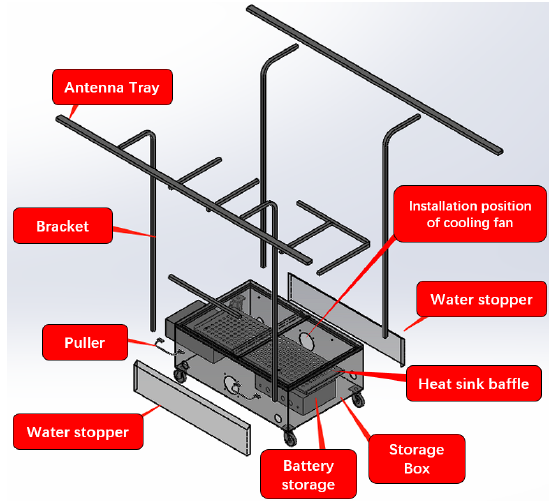
Figure 13. Design of outdoor test